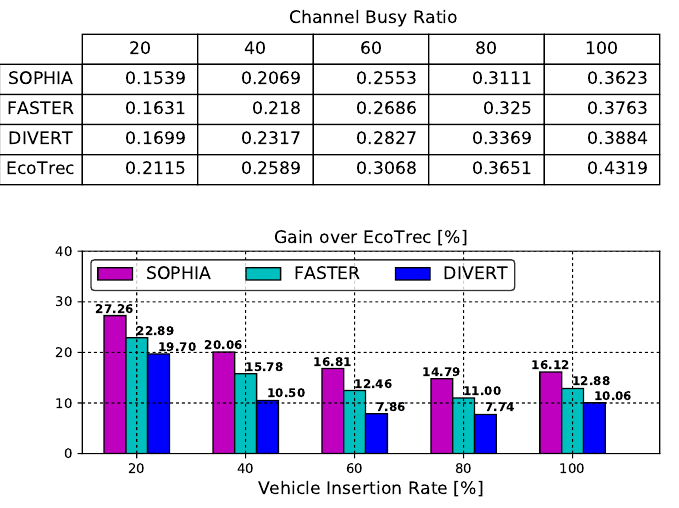
Figure 4. Control Channel